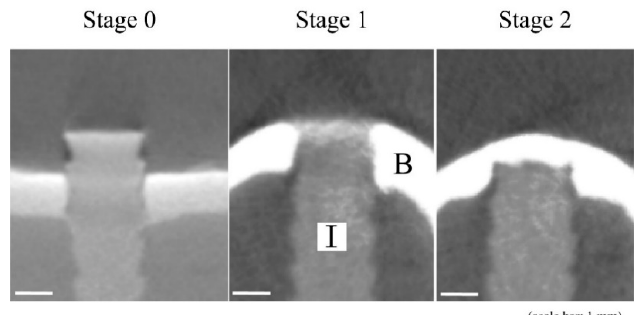
Figure 2. Radiological classification of bone bridging above implant by modified Goldberg classifi- cation [10]. The stage of 0 indicated no bone bridging, 1 indicated possible bone bridging, and 2 indicated complete bone bridging above the implant. B, bone; I, HA-PLLA threaded pin.